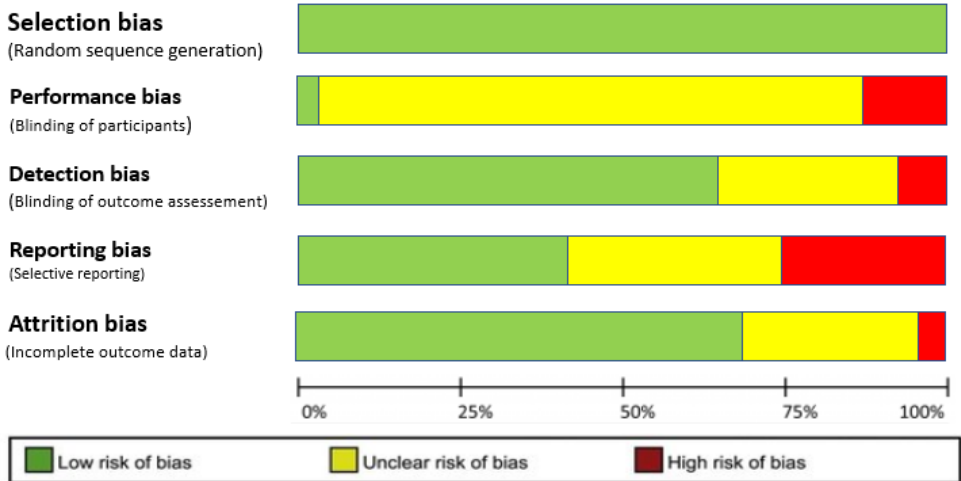
Figure 2. Risk of bias graph of included studies. The colors represent the quality of the studies: red = high risk, yellow = uncertain, green = low risk.